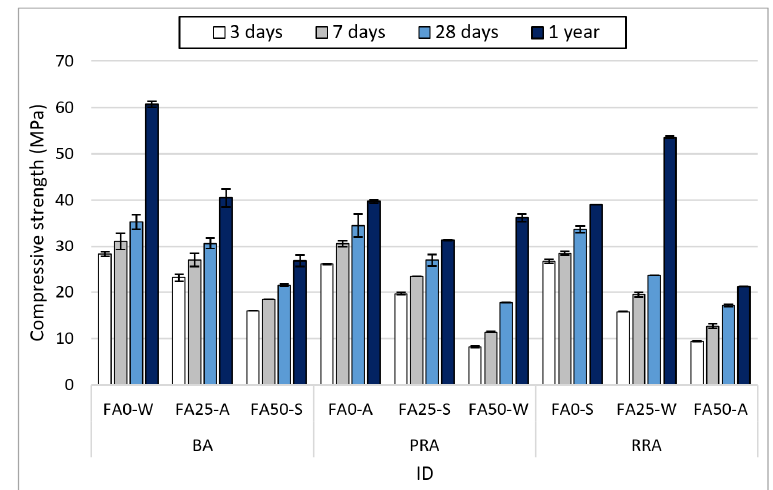
Figure 7. Compressive strength of concrete.